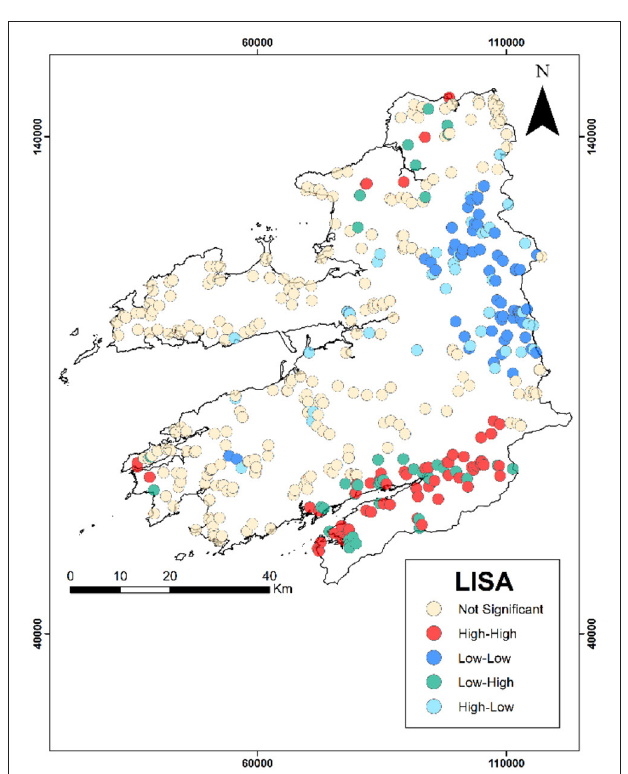
FIGURE 4 | Hot-spot distribution of